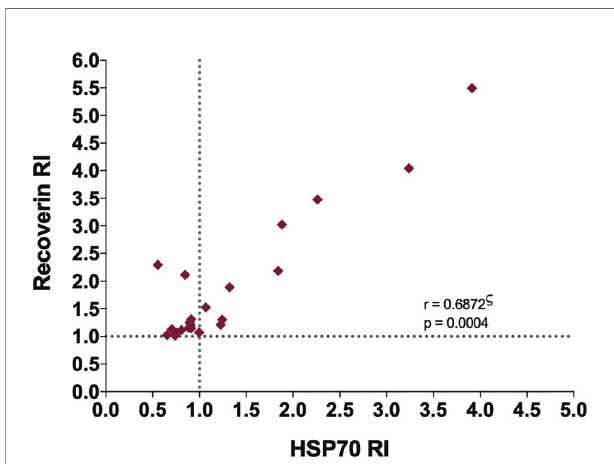
TABLE 3 | Presence of autoantibodies and clinical characteristics of patients with neuro-ophthalmic toxoplasmosis and CCT without OT.